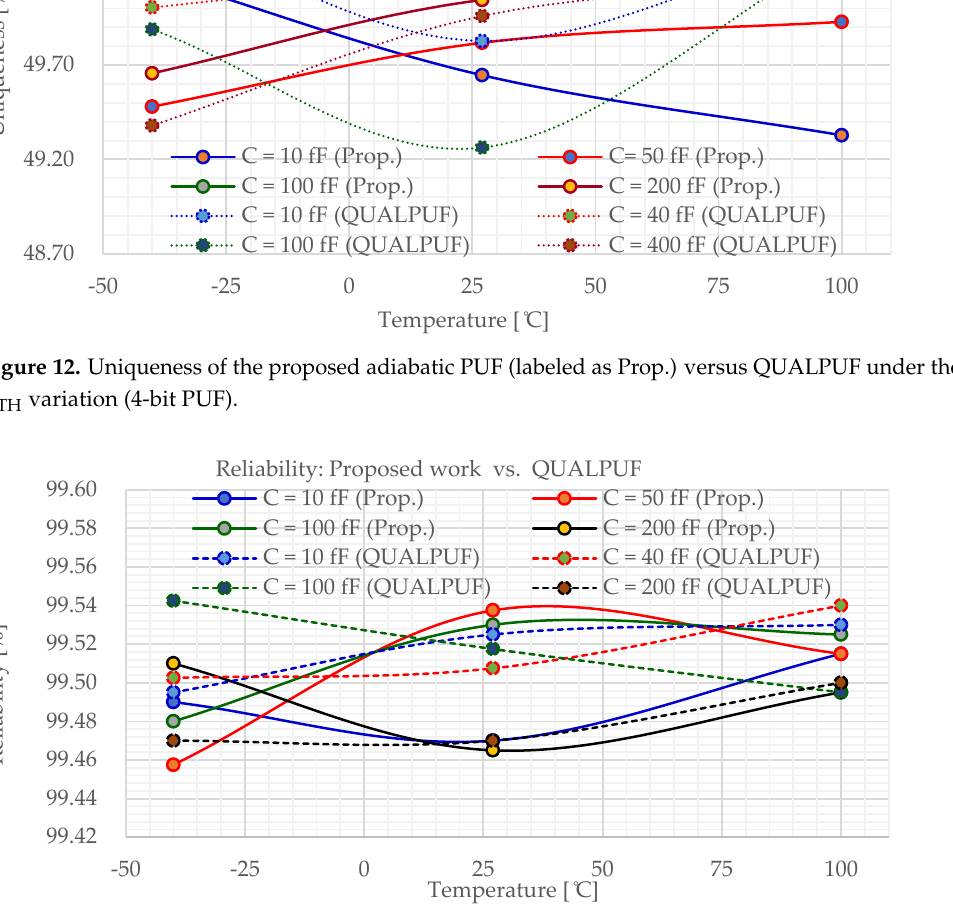
Figure 13. Reliability of the proposed adiabatic PUF (labeled as Prop.) versus QUALPUF under the V TH variation (4-bit PUF).